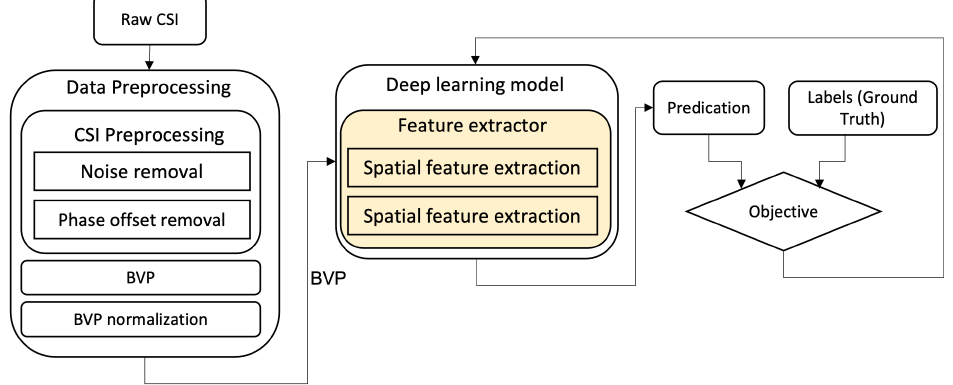
Figure 2. Pipeline of Widar3.0 paper’s activity recognition using WiFi CSI data, taken from